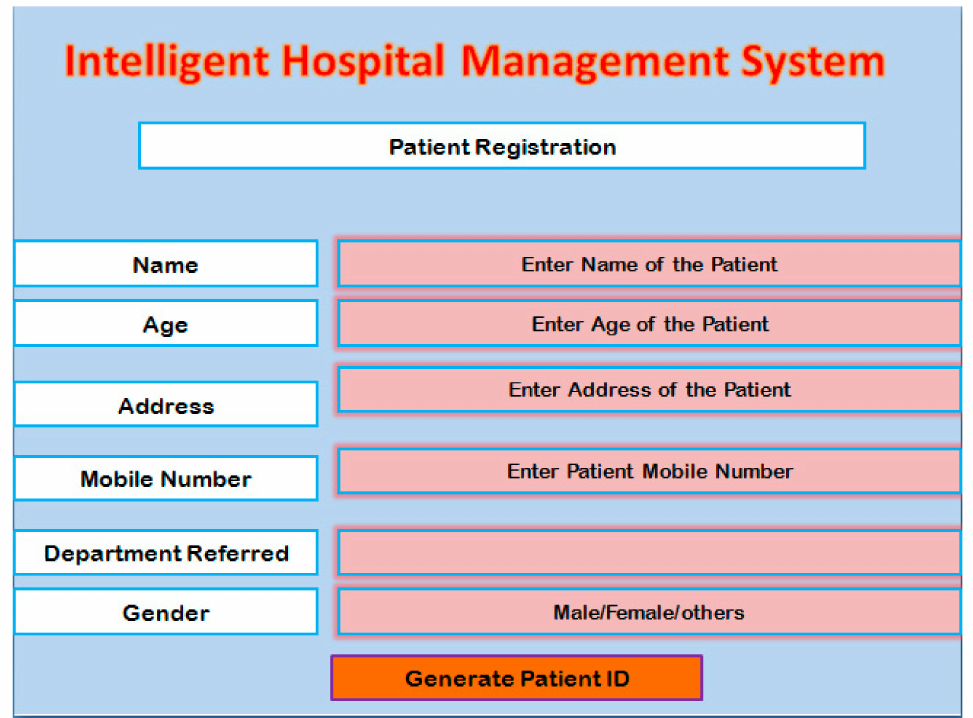
Figure 2. A patient registration